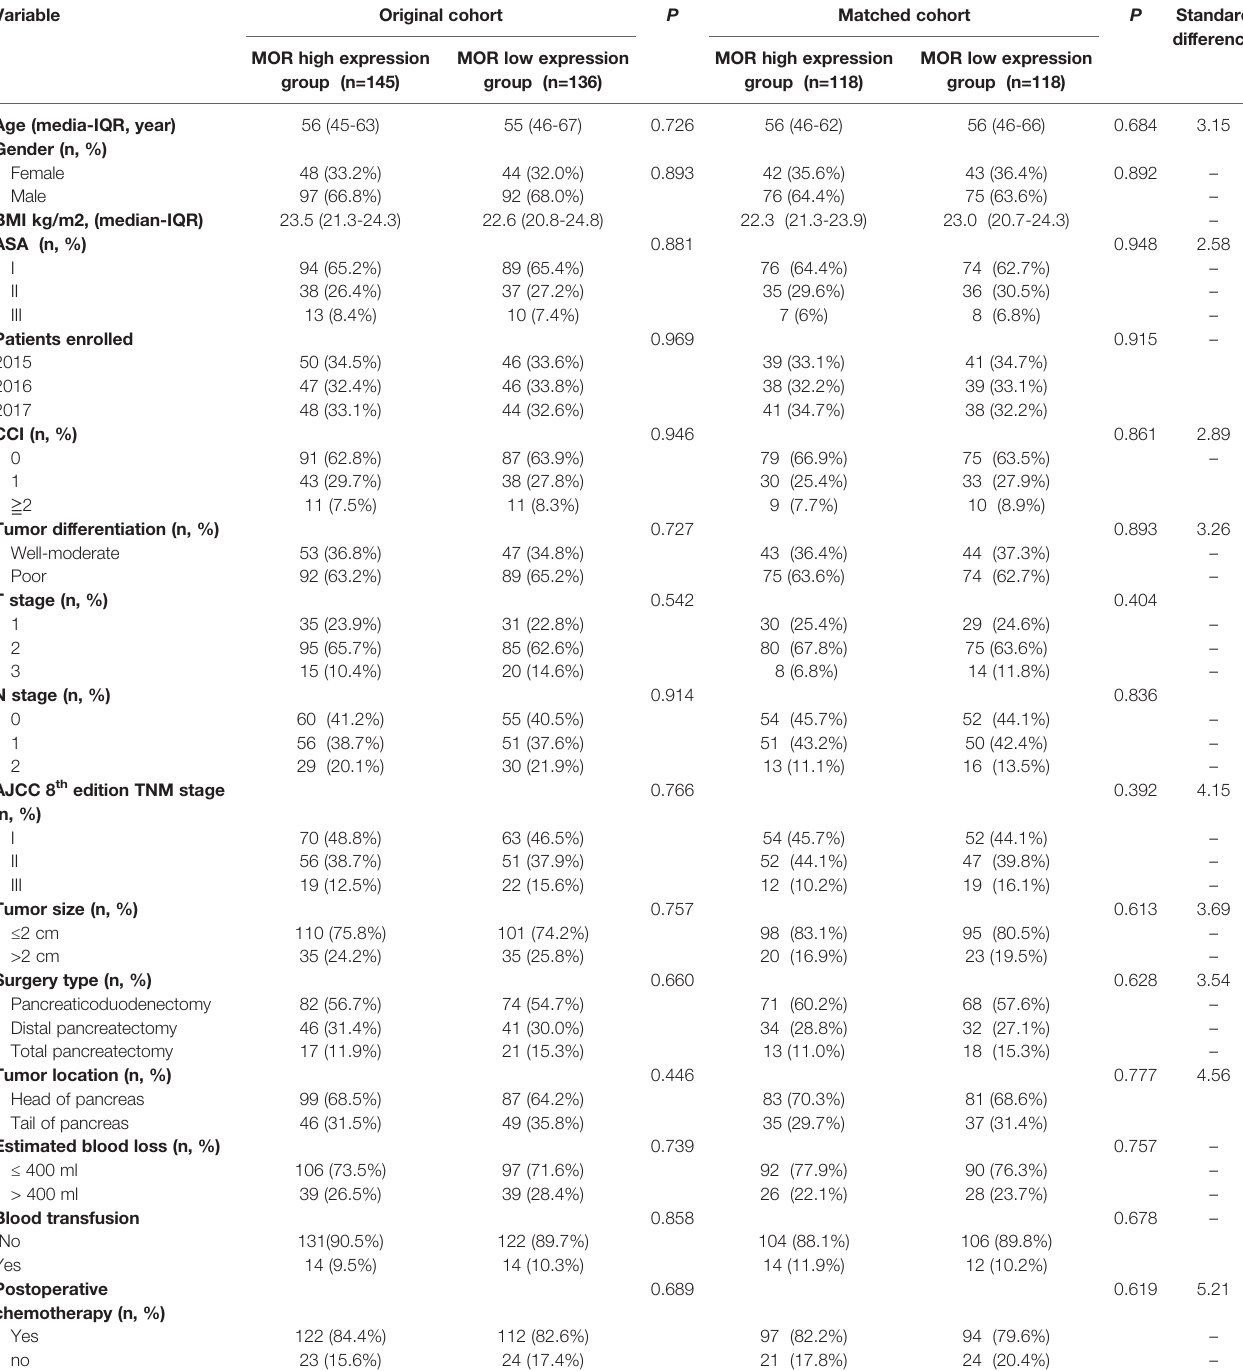
TABLE 1 | Baseline characteristics of patients in both